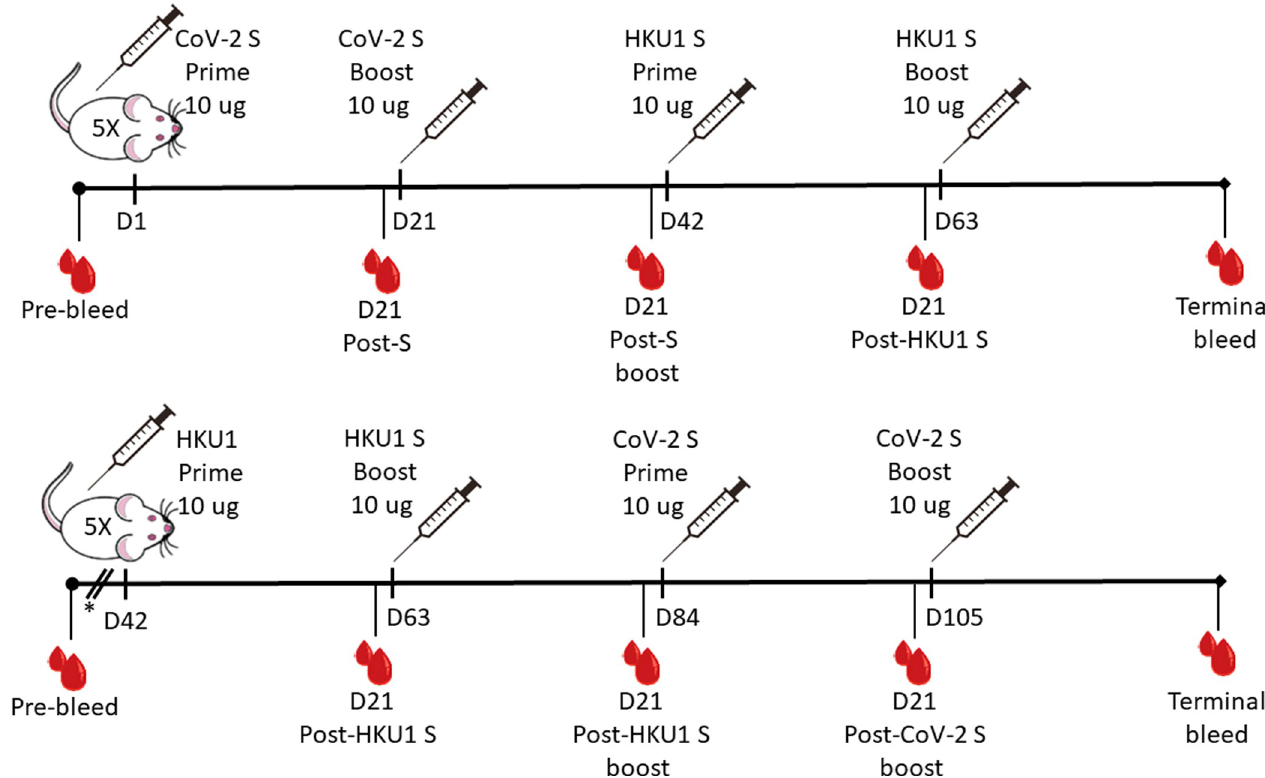
Fig 1. Schematic of intramuscular spike protein administrations in groups of five BALB/c mice. Group 1 received prime and boost with SARS-CoV-2 spike, followed by prime and boost with HKU1 spike. Group 2 received a reciprocal administration regimen, with prime and boost with HKU1 spike, followed by prime and boost by HKU1 spike. D, days post-administration; S, spike; SARS-CoV-2, severe acute respiratory syndrome coronavirus 2. � These mice were immunized with nucleocapsid protein 21 and 42 days prior to utilization for this study.